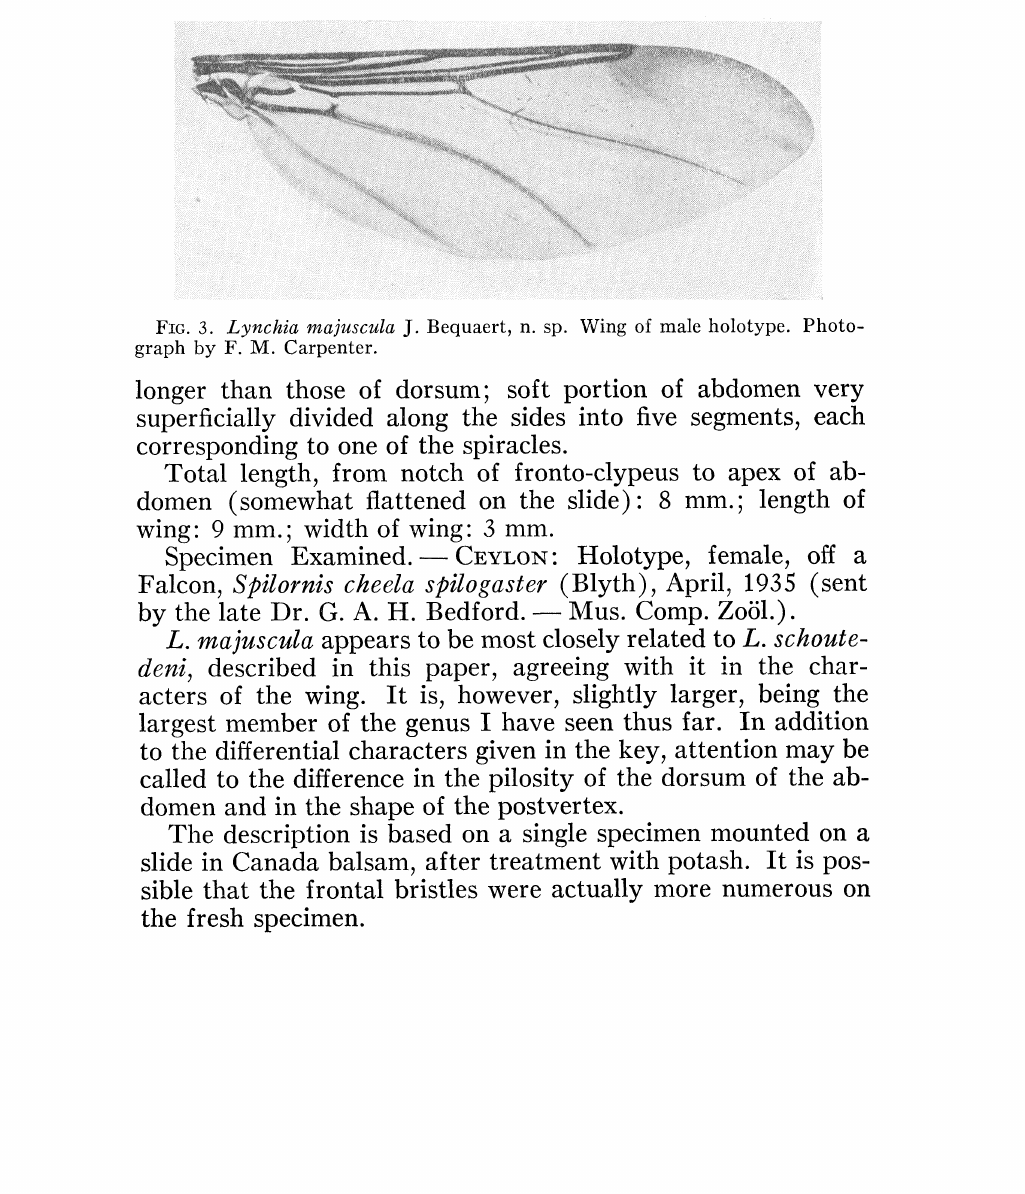
FIG. 3. Lynchia majuscula J. Bequaert, n. sp. Wing of male holotype. Photo- graph by F. M.